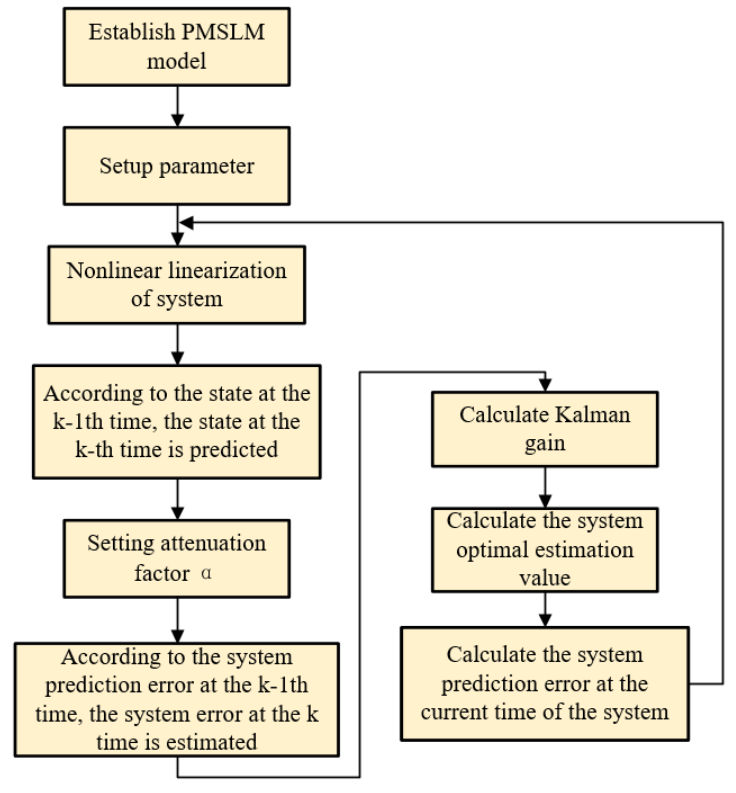
Figure 2. AMEKF flow chart.